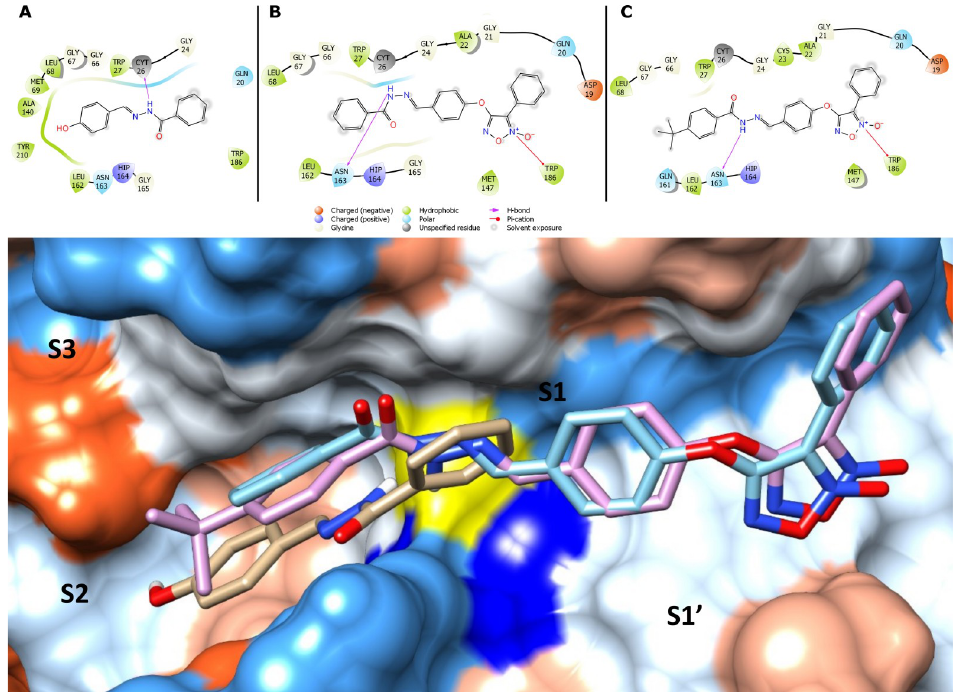
Fig 3. Ligand-CPB complex predicted by molecular docking. Possible poses and interactions performed by compounds 14a (A) , 4a (B) and 4e (C) against CPB. Superposition of 4a (beige), 14a (cyan) and 14e (pink). The yellow surface represents CYS26 and dark blue is